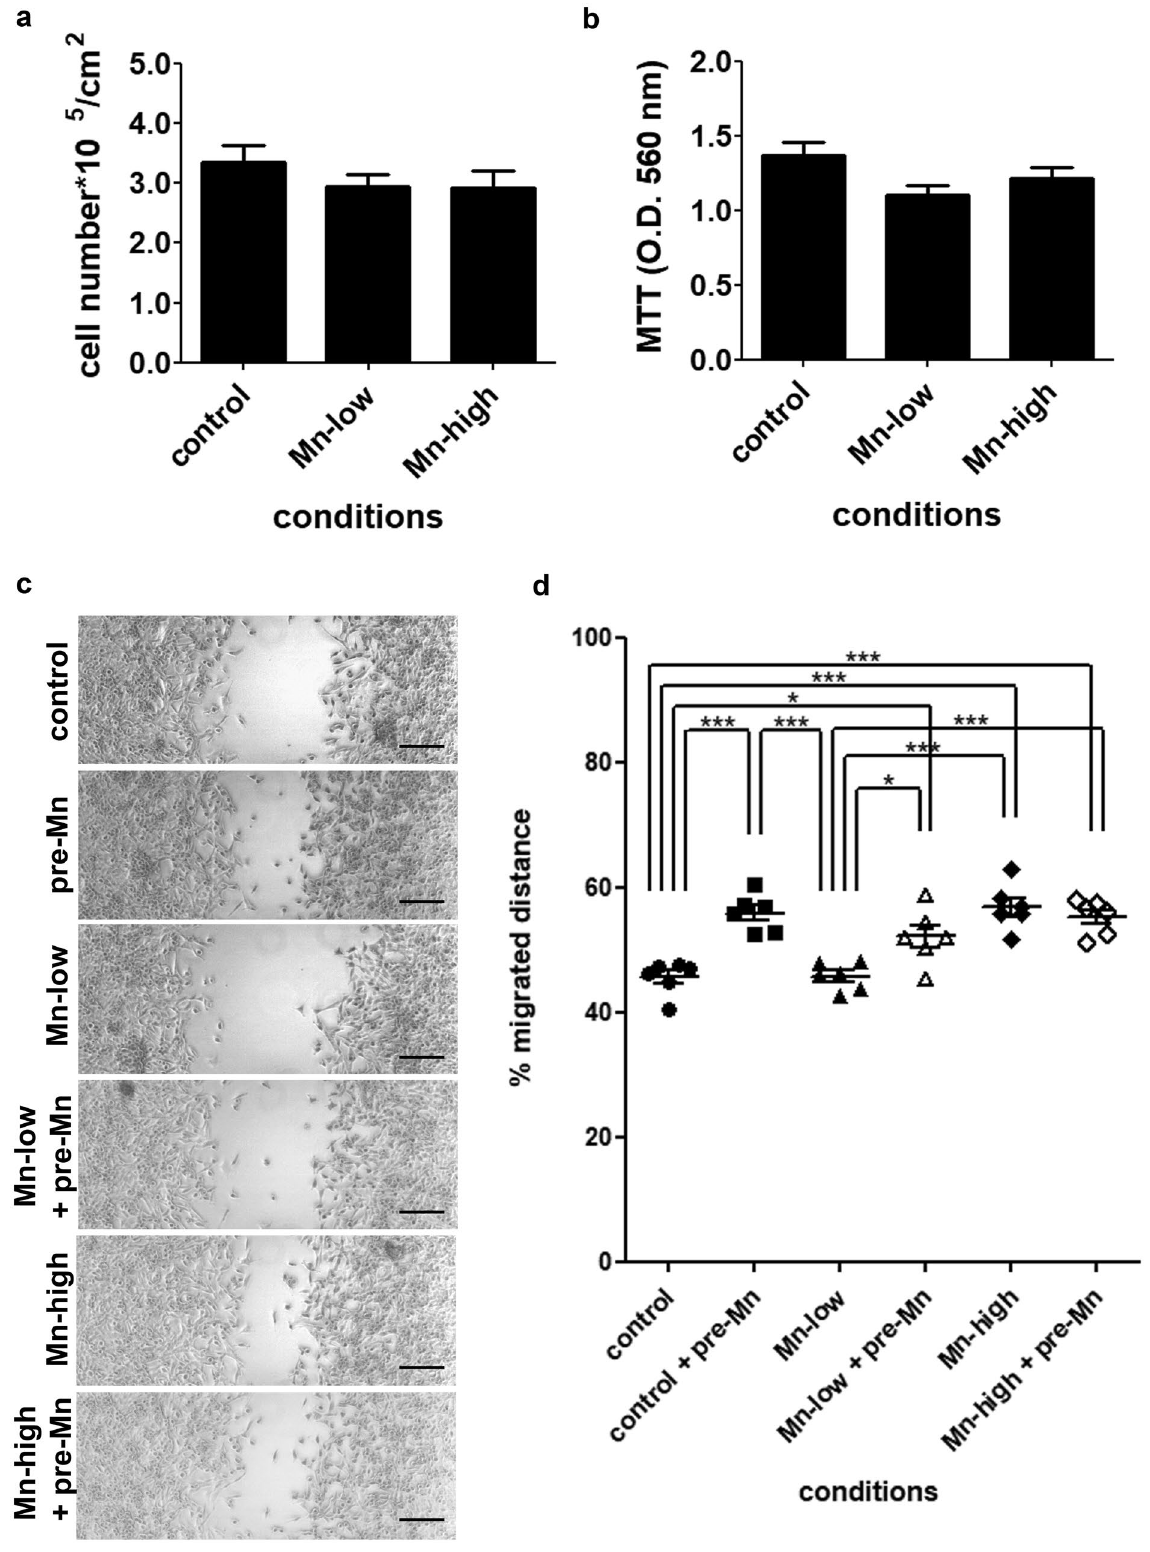
Figure 5. Tumor cells cultured in manganese-low and manganese-high conditions present different migration patterns. LLC cells were cultured in Mn-low and Mn-high conditions for 48 h and ( a ) cell growth was evaluated by counting live, adhered cells using trypan blue. ( b ) Cell viability was evaluated by the MTT assay. LLC cell migration pattern was evaluated in wound healing assays by intermittent monitoring at 0 h and 12 h. Cells were ( c ) imaged and migrated distance was ( d ) quantified. Mn-low (standard high glucose DMEM + Mn-low FBS); Mn-high (standard high glucose DMEM + Mn-high FBS). Scale bars 200 µm. Cell growth assay N = 4; MTT assay N = 6; wound healing assay N = 6. *p<0.05; ***p<0.0001, one-way ANOVA test and Bonferroni’s multiple comparison